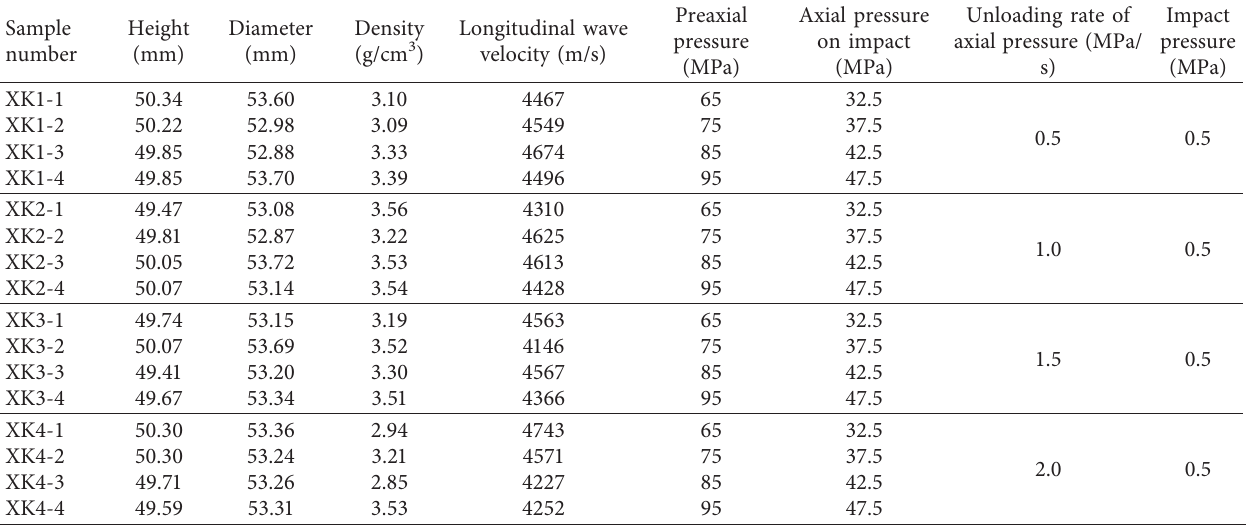
Table 2: Test scheme of skarn during unloading under high static stress frequent disturbances. Sample